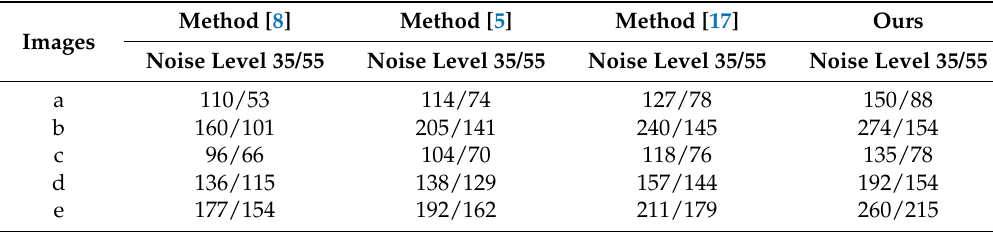
Table 3. The comparison of the correct matching pairs between denoised images and the corresponding clean UAV images obtained by SIFT.